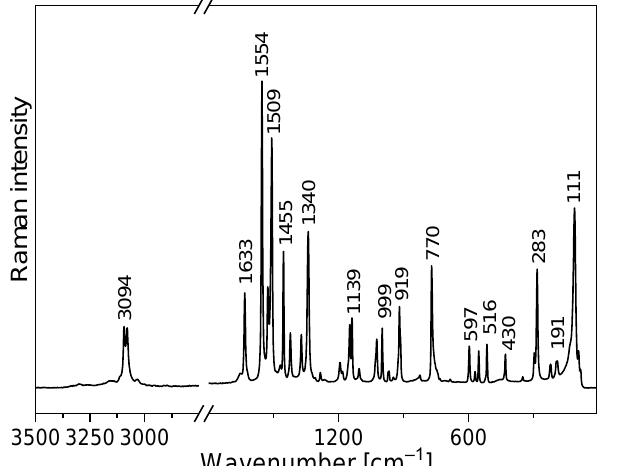
Figure 6. Raman spectrum of TPa-NH 2 .